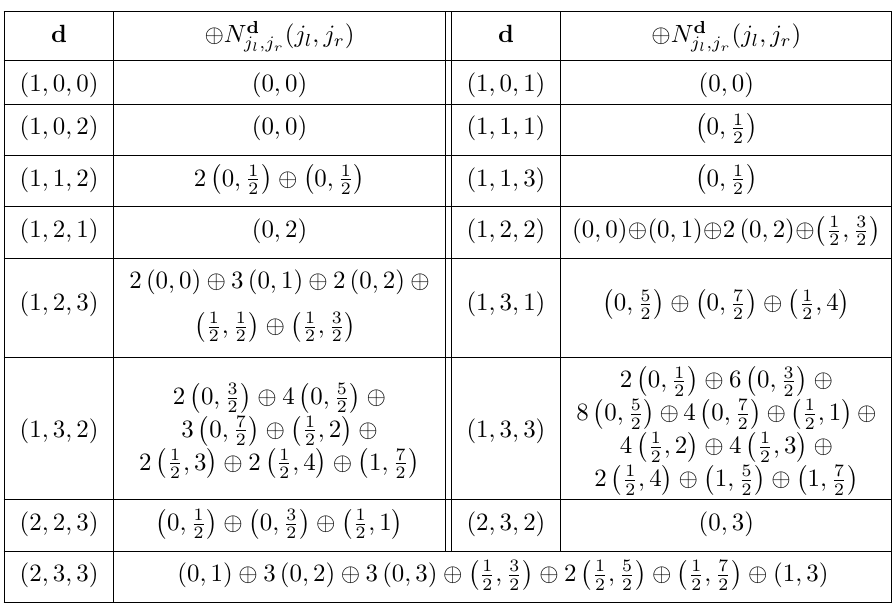
Table 28. BPS spectrum of P 2 ∪ F 6 + 1 Sym for d 1 ≤ 2 and d 2 , d 3 ≤ 3 . Here, d = ( d 1 , d 2 , d 3 ) labels the BPS state with charge d 1 ( ˜ m − 2˜ φ 2 ) + d 2 (3˜ φ 1 − 2˜ φ 2 ) + d 3 ( − ˜ φ 1 + 2˜ φ 2 ) . The d 1 = 0 sector is the same with that of P 2 ∪ F 6